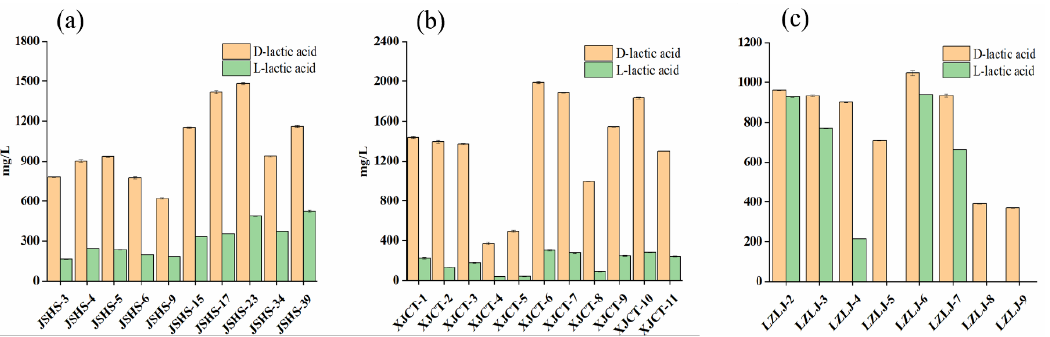
Figure 6. ( a – c ) Histograms of D-lactic acid and L-lactic acid in soy sauce aroma-type vintage Baijiu (JSHS, XJCT) and strong aroma-type vintage Baijiu